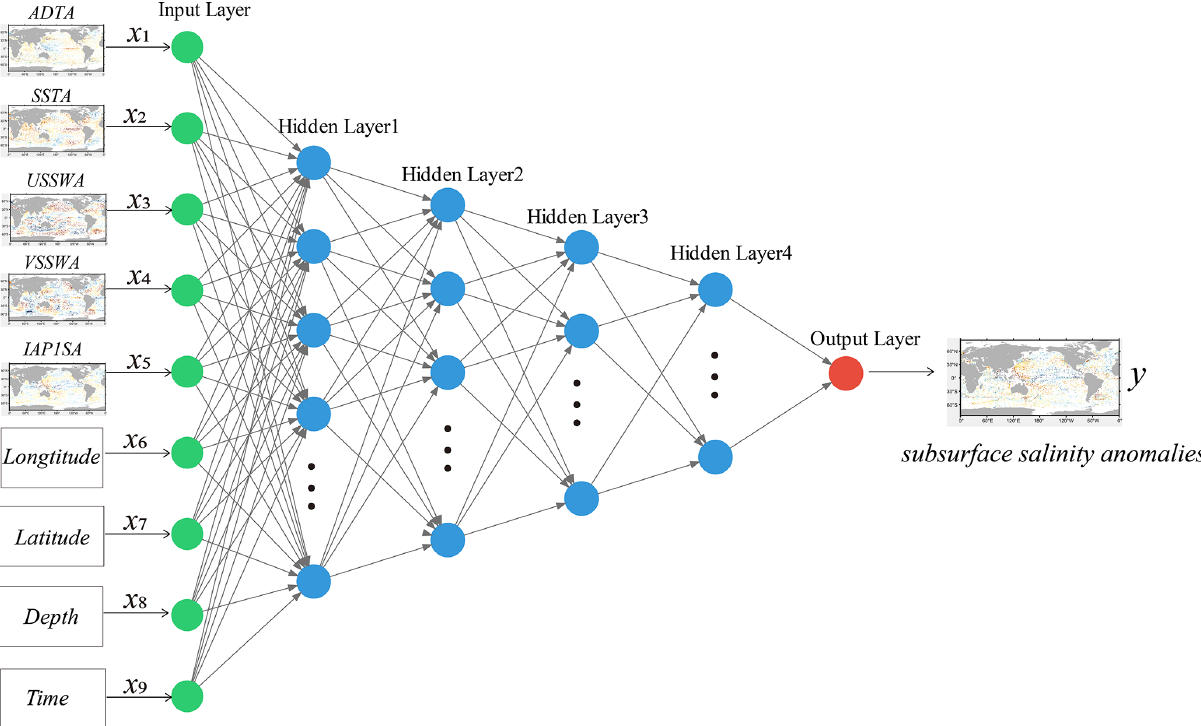
Figure 1. Schematic diagram of subsurface salinity reconstruction by the FFNN